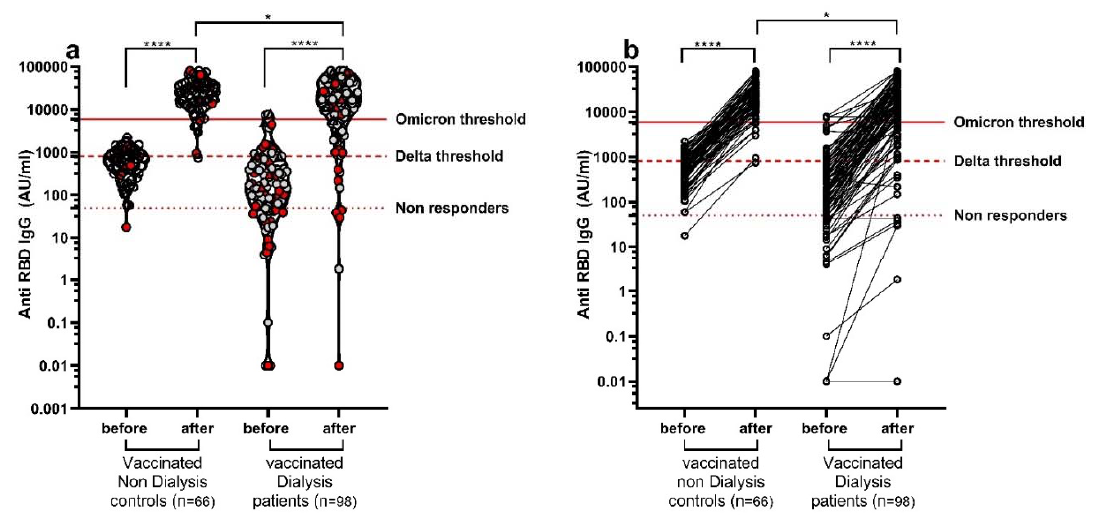
Figure 2. Anti-SARS-CoV-2 spike1 IgG titer was significantly upregulated after the first booster. Anti-SARS-CoV-2 spike protein IgG antibody titer in hemodialysis patients and controls before and 2–3 weeks after the first booster. ( a ) In red: patients and volunteers infected with SARS-CoV-2 after the booster dose during the 280-day study follow-up. ( b ) Changes in antibody titers in each participant. All dialysis patients but one showed upregulation of anti-S1 antibodies. * p < 0.05; **** p <